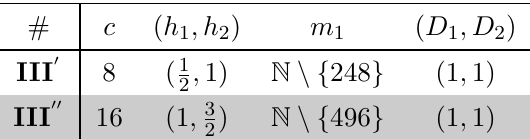
Table 1. Previously uncharacterized admissible character solutions to the (3 , 0) MLDE. The ones of type III and V have Y that are fractional and cannot be made integer by rescaling the degeneracies. i